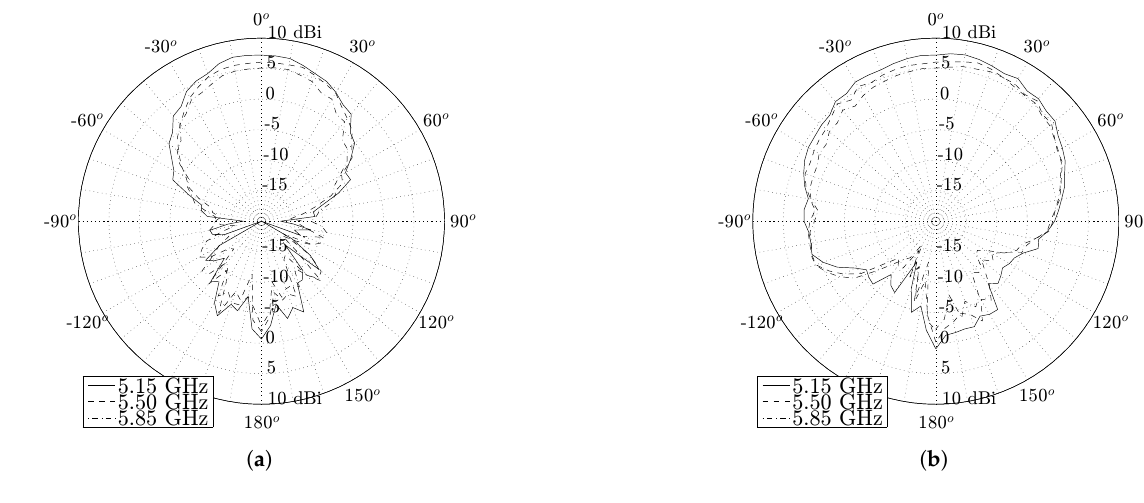
Figure 12. Free space radiation pattern of the SMA antenna. ( a ) H-plane; ( b ) E-plane.